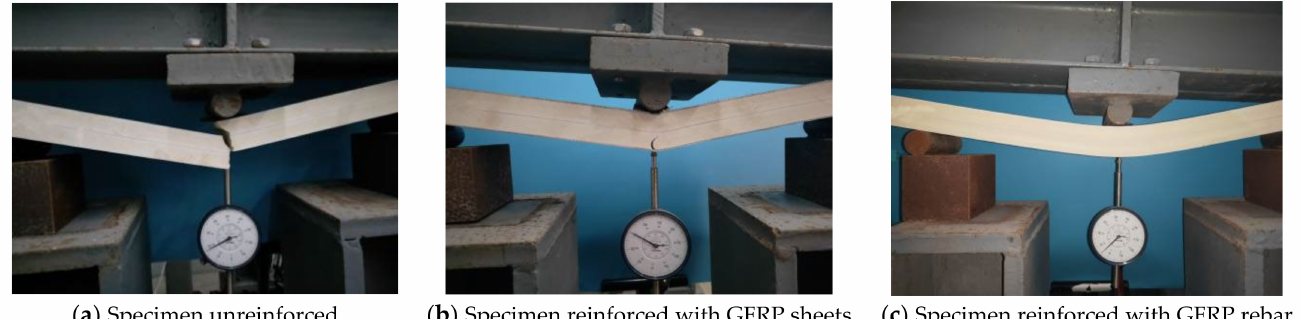
Figure 5. Failure mode of PVC-based WPC